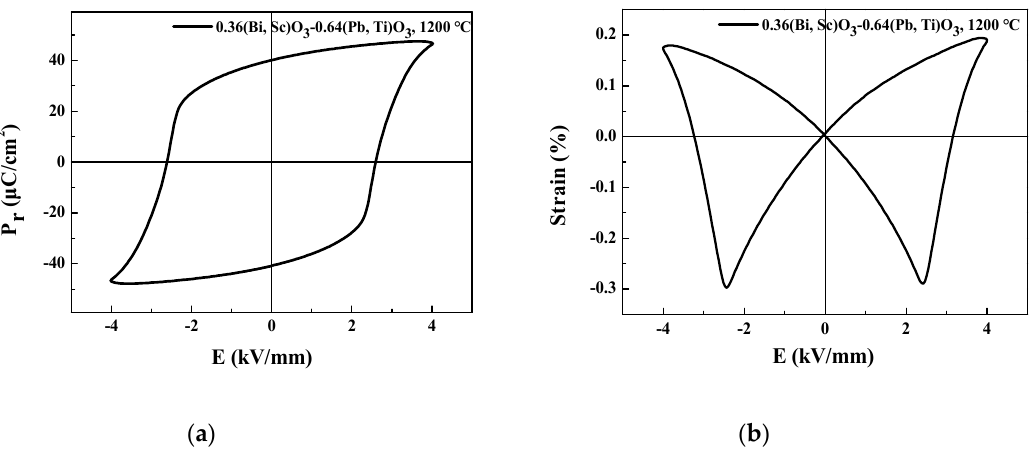
Figure 4. ( a ) Polarization versus electric field (P-E) hysteresis loops of the BS-PT piezoelectric ceramics at the sintering temperature of 1200 °C. ( b ) Electric field dependent strain (S-E) curves for the BS-PT piezoelectric ceramics.